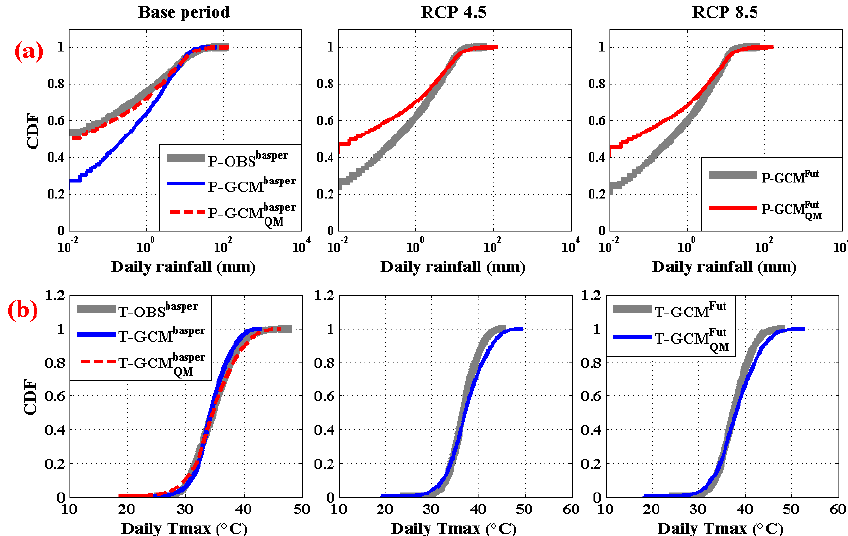
Figure 2. (a) Comparison between the empirical cumulative density function of the observed rainfall data and the one provided by the MIROC-ESM model, before (dashed line) and after (solid line) the application of the QM method: the Base period and future climate (RCP4.5 and RCP8.5) over the study area. (b) Same comparison done for T max by using a Gaussian distribution for the MPI-ESM-LR